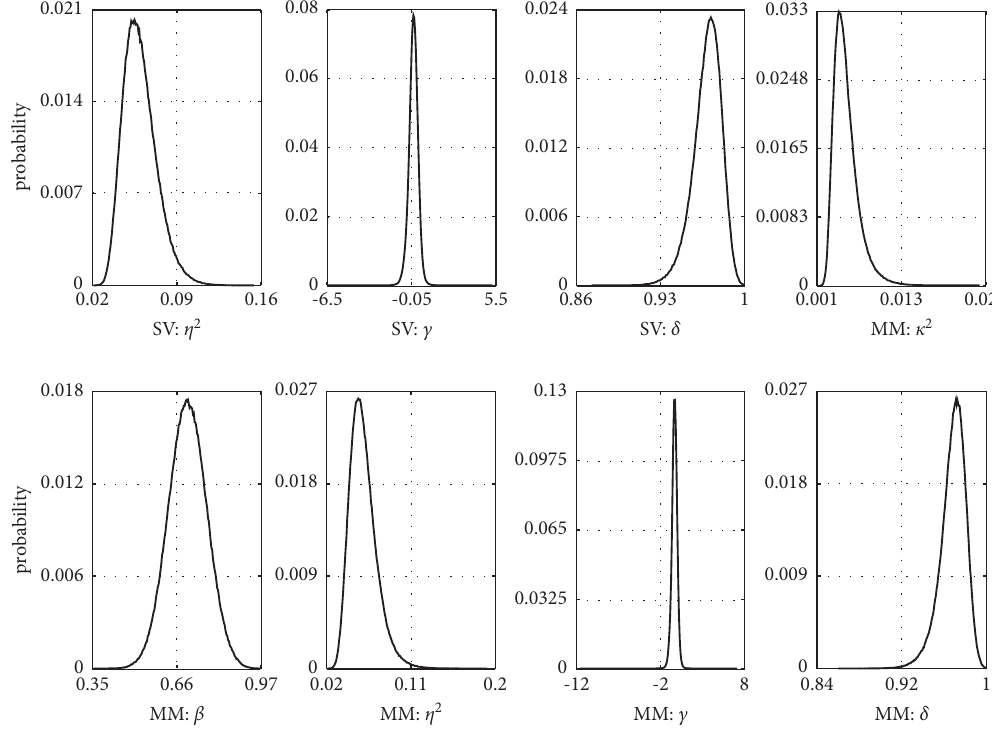
Figure 1: The posterior densities of parameters for SV and MM models. Table 5: The estimated result for SV model using simulated datasets.